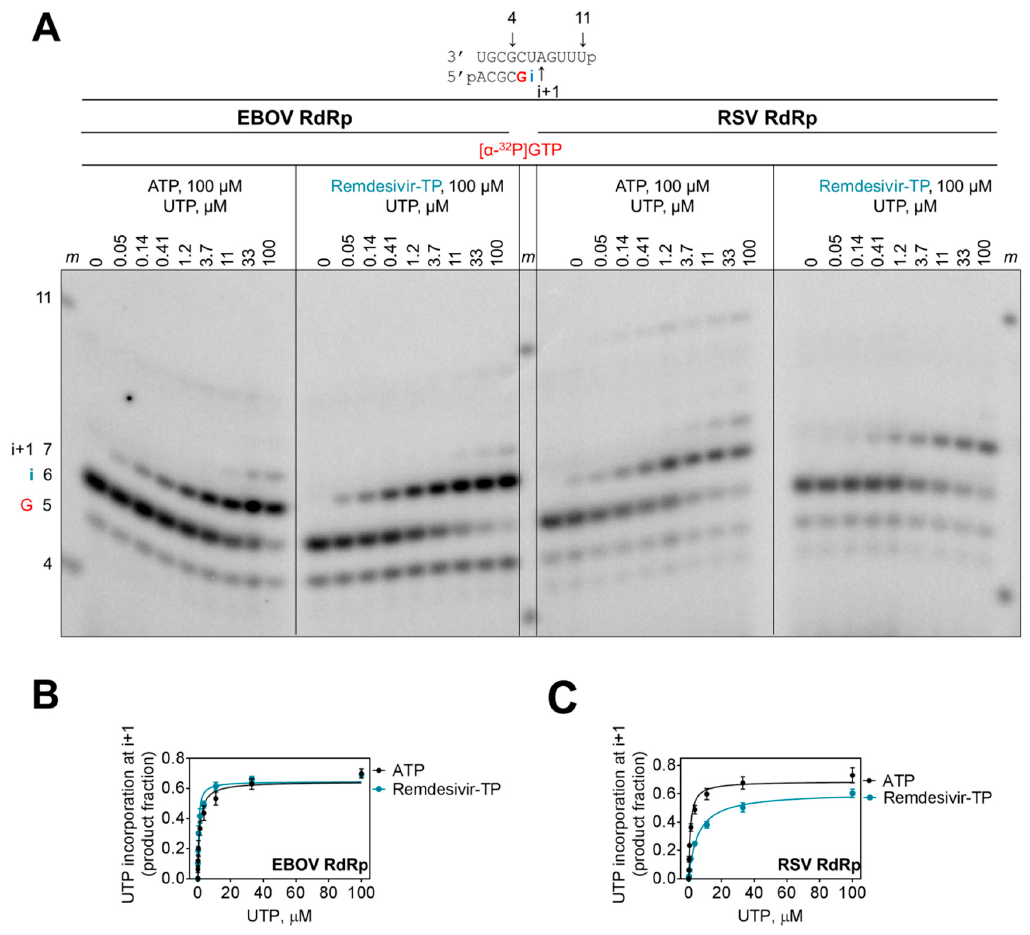
Figure 4. Effect of remdesivir-MP on the efficiency of the next nucleotide incorporation event. ( A ) RNA synthesis was monitored with purified EBOV RdRp and RSV RdRp complexes in the presence of [ α - 32 P]GTP, ATP, or remdesivir-TP, respectively, and increasing concentrations of UTP. G indicates incorporation of the radiolabeled nucleotide, i indicates incorporation of AMP or remdesivir-MP, and i+1 indicates incorporation of UMP. High concentrations of UTP also promote UMP misincorporation at the following position. ( B , C ) Graphic representation of data shown in ( A ).